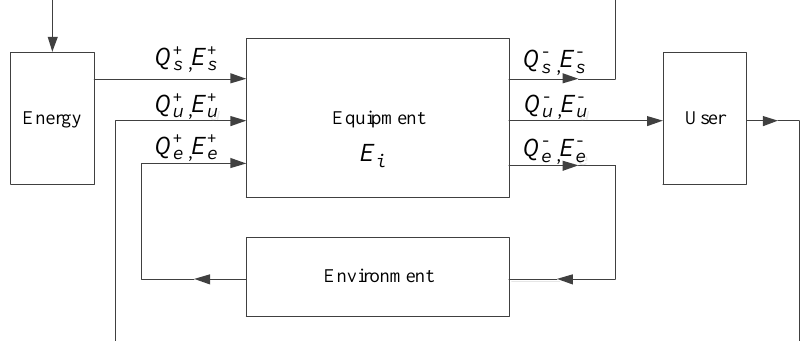
, Q + u , Q + e : Heat flow rates supplied to the equipment by the energy, , Q + , Q + : Heat flow rates supplied to the equipment by the energy, S u e S , Q − u , Q − e : Heat flow rates exported to the energy, user and , Q – , Q – : Heat flow rates exported to the energy, user and S u e S , E + u , E + e : Exergy flow rates supplied to the equipment , E + , E + : Exergy flow rates supplied to the equipment S u e S , E − u , E − e : Exergy flow rates exported to the energy, , E – , E – : Exergy flow rates exported to the energy, S S u e